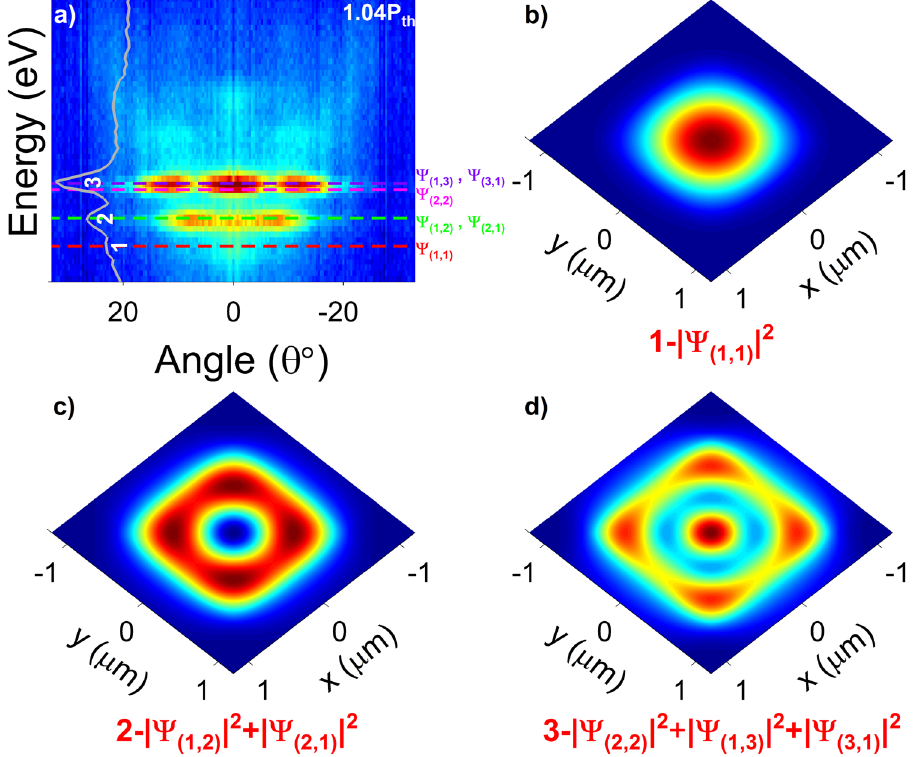
Figure 5. Quantum-confined polariton levels accounting for the observed k-space pattern. ( a ) Angle- dependent room-temperature PL from membrane 5, measured with an excitation power density of 1.04 · P th . The corresponding spectral data at k || = 0° are plotted within the image, marking the levels ‘1’, ‘2’ and ‘3’. The dashed lines mark the respective simulated polariton levels. ( b – d ) Plots of the real-space squared wave-functions associated to ( b ) level ‘1’, ( c ) level ‘2’, and ( d ) level